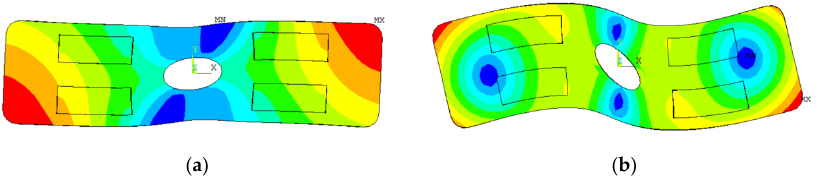
Figure 2. Operating modes of the traveling wave vibrator: ( a ) Longitudinal mode; ( b ) Bending mode.